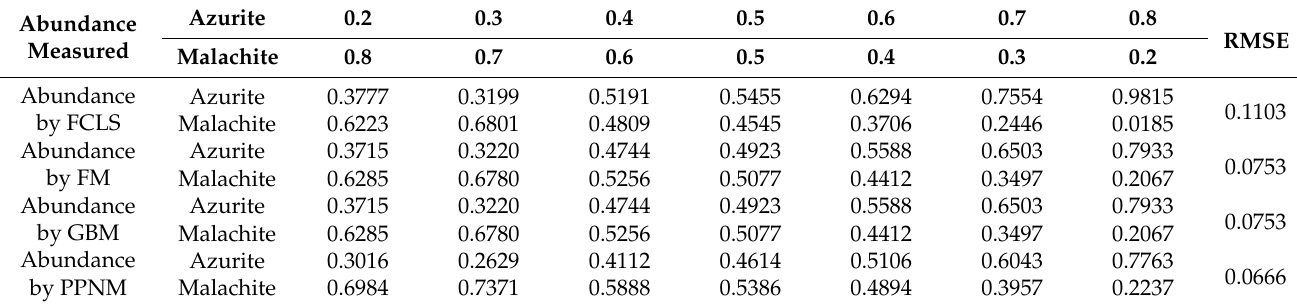
Table 3. Abundance estimated by different approaches for mixed pigment samples of azurite and malachite.